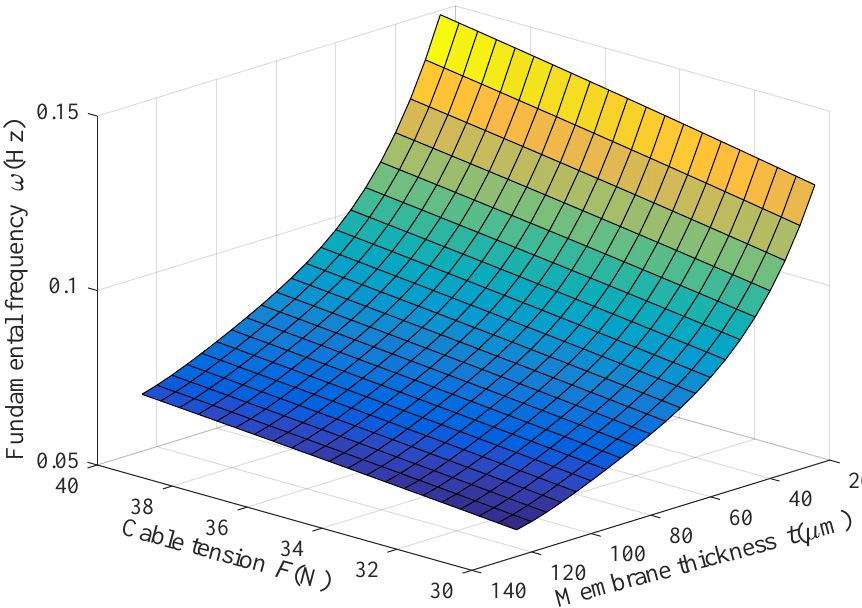
Figure 11. RS method applied to the design of space membrane deployable mechanism.